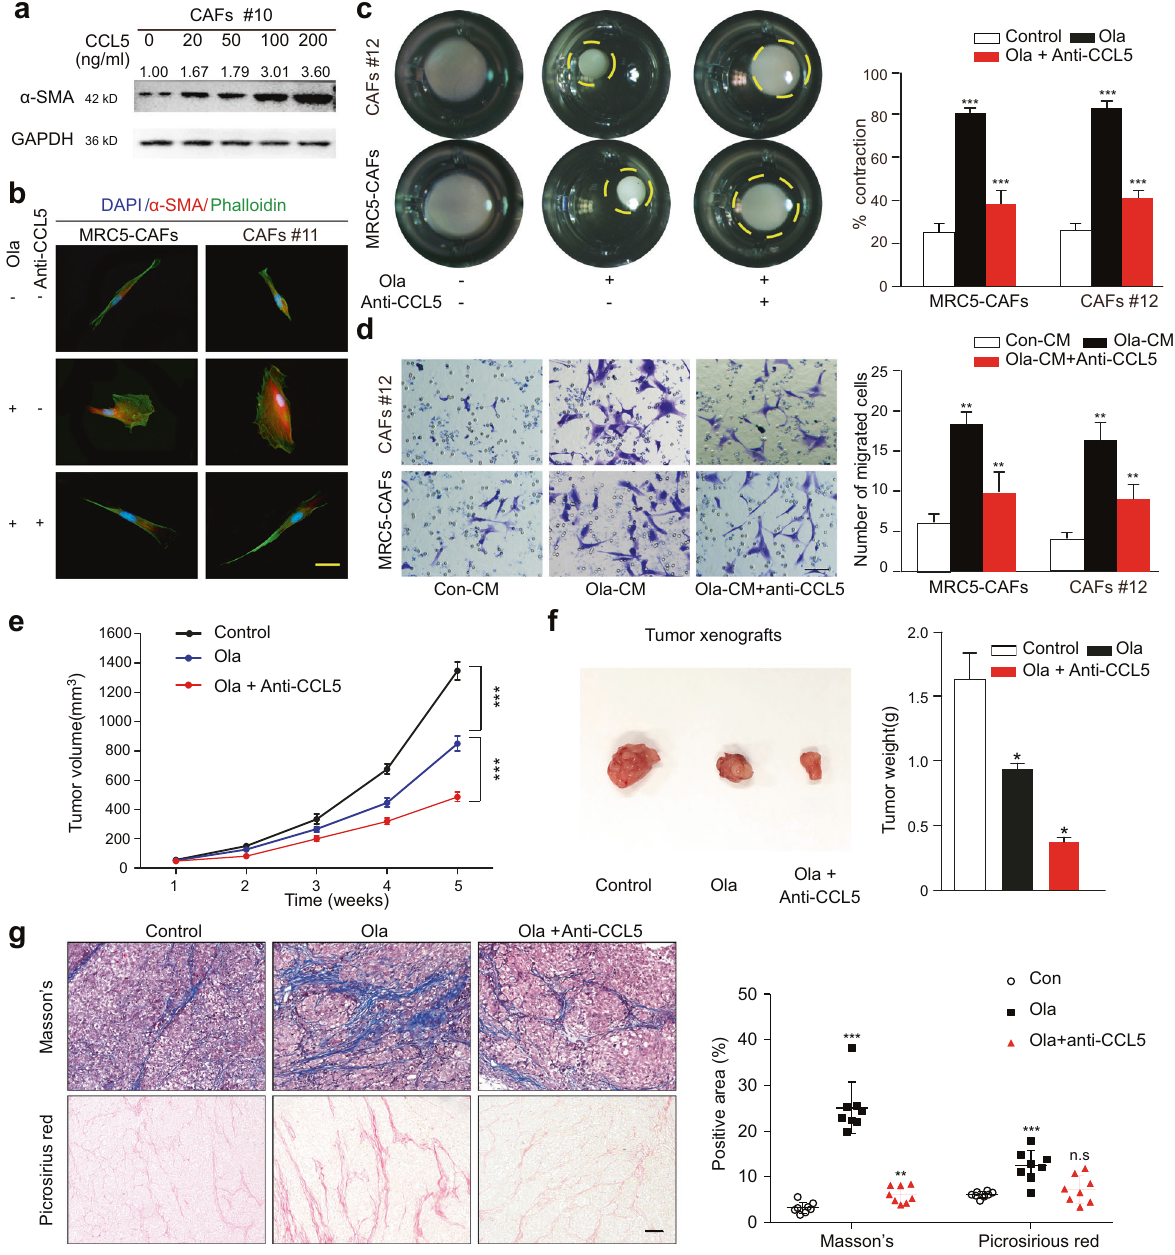
Fig. 5 CCL5 is required for PARPi-induced stromal fi broblast activation. a Immunoblotting of α -SMA in primary CAFs after exogenous CCL5 administration. GAPDH served as the loading control. Relative densitometric values are labeled in the photographs. b The CCL5 neutralizing antibody suppressed the α -SMA elevation and cytoskeletal stretch of MRC5-CAFs and primary CAFs in response to Ola. Scale bar, 10 µm. c Representative images and quanti fi cation of the collagen contraction assays of MRC-CAFs and primary CAFs under treatment of Ola with or without CCL5 neutralizing antibodies. d Representative images and quanti fi cation of CAFs transwell assays using conditional medium derived from CAFs under treatment of Ola with or without CCL5 neutralizing antibodies. e Tumor volumes (mm 3 ) of SKOV3 xenografts estimated using calipers per week for 35 days after tumor cell injections. ( n = 8 mice per group). f Bright fi eld images and weight quanti fi cation of subcutaneous tumors from mice ( n = 8) injected intraperitoneally with vehicle or Ola or the combination of Ola and CCL5 neutralizing antibodies for 28 days after the tumor implantation. g Representative images and quanti fi cation of Masson ’ s trichrome staining and picrosirius red staining of the tumor tissue derived from SKOV3 xenografts under the indicated treatment. Measurements were taken from distinct samples ( n = 8). Scale bar, 50 µm. Data are expressed as mean ± s.e.m., * p < 0.05; ** p < 0.01; *** p <